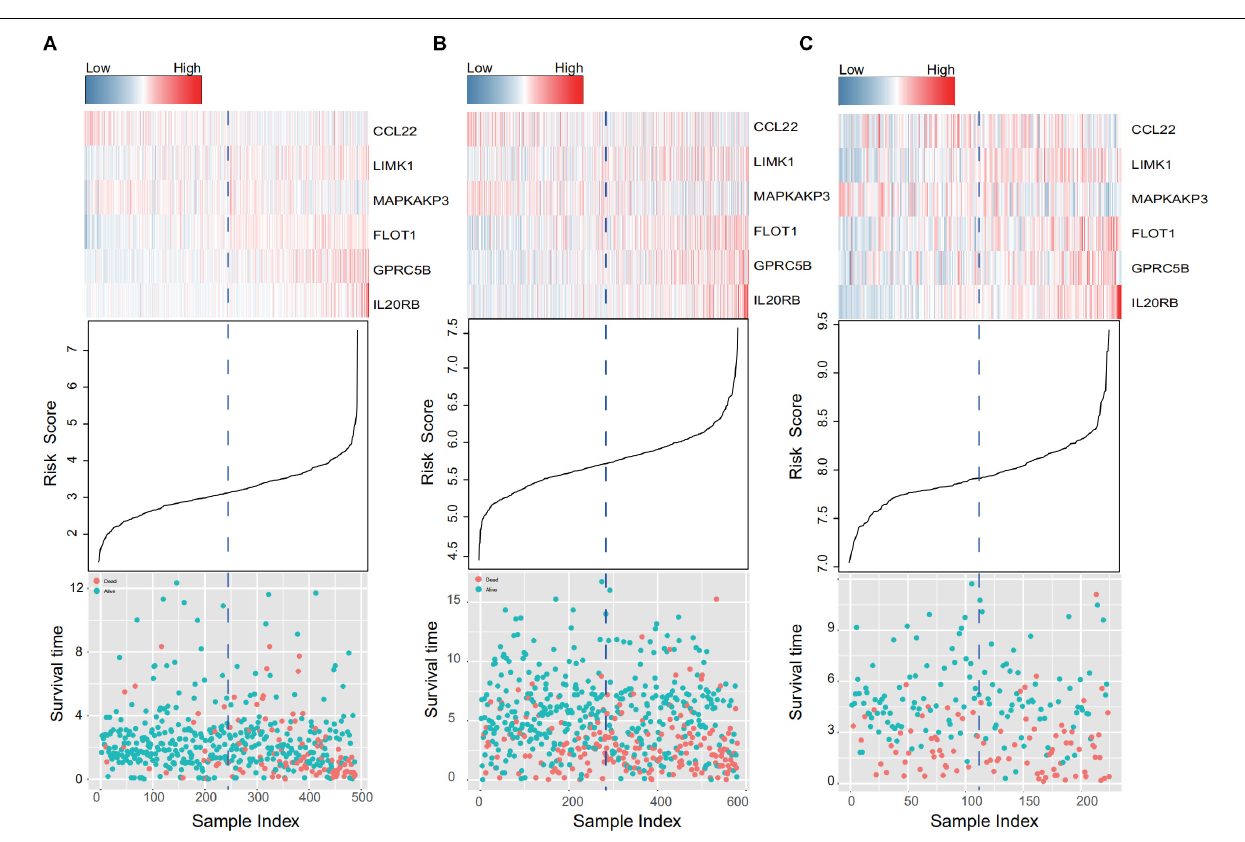
35%. Via time-ROC ( Figure 5B ), the AUC values in the training group at 1, 3, and 5 years were 0.822 (95% CI: 0.761–0.883), 0.835 (95% CI: 0.775–0.895), and 0.798 (95% CI: 0.715–0.881), respectively. An external group (GSE39582) was used for model